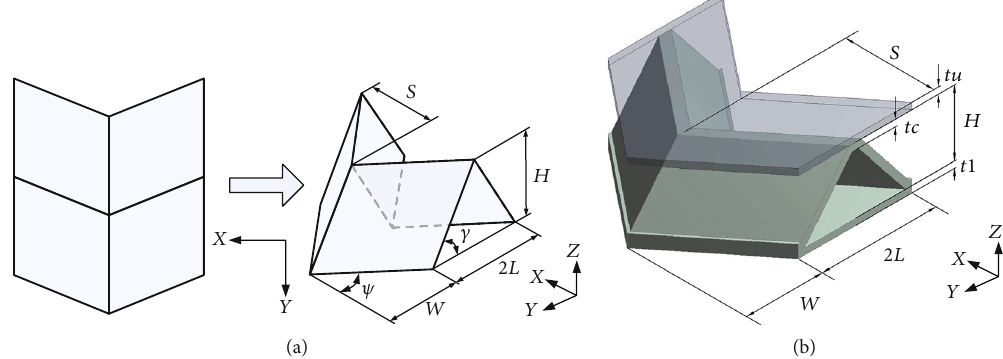
Figure 2: Geometric parameters of (a) a typical V-pattern folded core unit cell and (b) a unit cell when web thickness is considered. Table 1: Material properties.